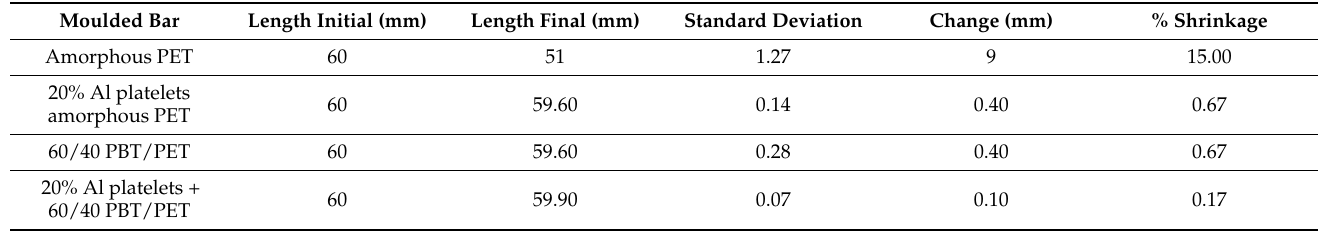
Table 5. Change in the length of the moulded bars (cut flexural bar) after annealing at 150 ◦ C. Moulded